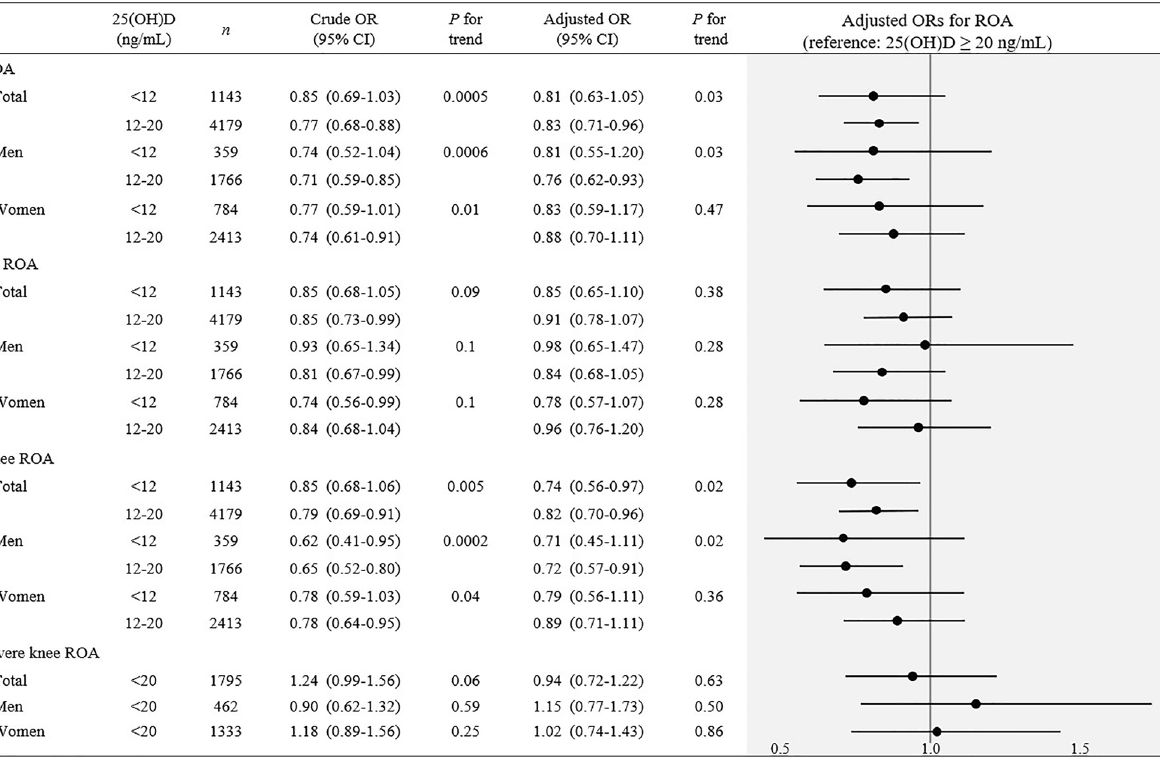
Figure 1. Crude and adjusted ORs (95% CI) of ROA by 25(OH)D status in adults 50 years and older from KNHANES 2010–2013. ROA indicates at least one incidence of ROA at the knee, lumbar spine, or hip